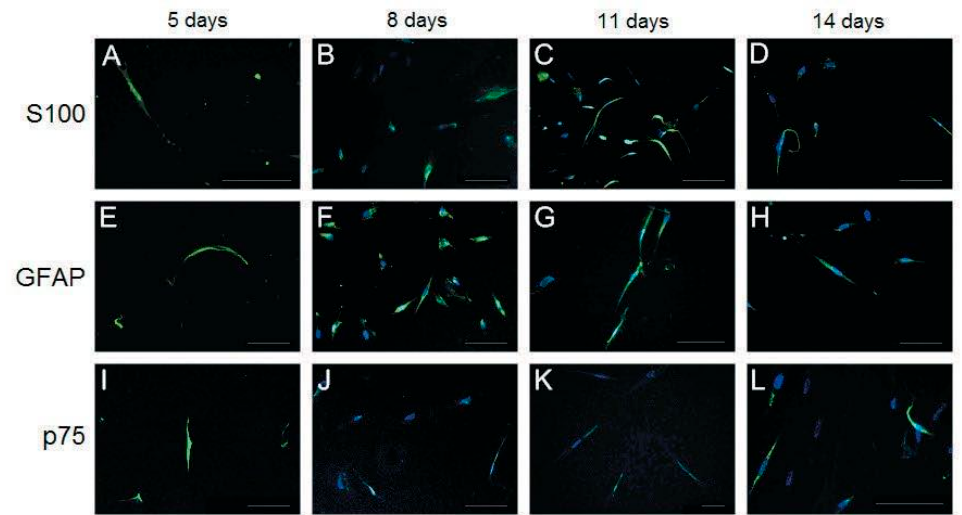
Figure 3. Immunofluorescence staining of differentiated placenta-derived multipotent stem cells (PDMCs) after culturing in the induction medium from Schwann cell-like cells for 5, 8, 11, and 14 days. Expression of S100 ( A – D ), GFAP ( E – H ), and p75 ( I – L ) was observed from days 5 to 14; however, the highest expression was exhibited on day 11 ( C , G , K ). Nuclei are labeled with DAPI (4 ′ ,6-diamidino-2-phenylindole) (blue). Bar, 100 µ m.